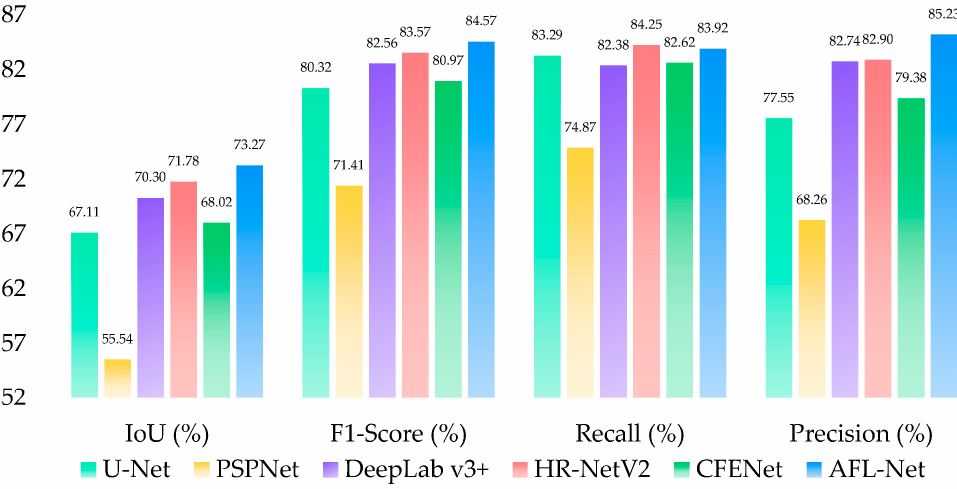
Figure 7. Comparative results from the selected models on the Massachusetts dataset.